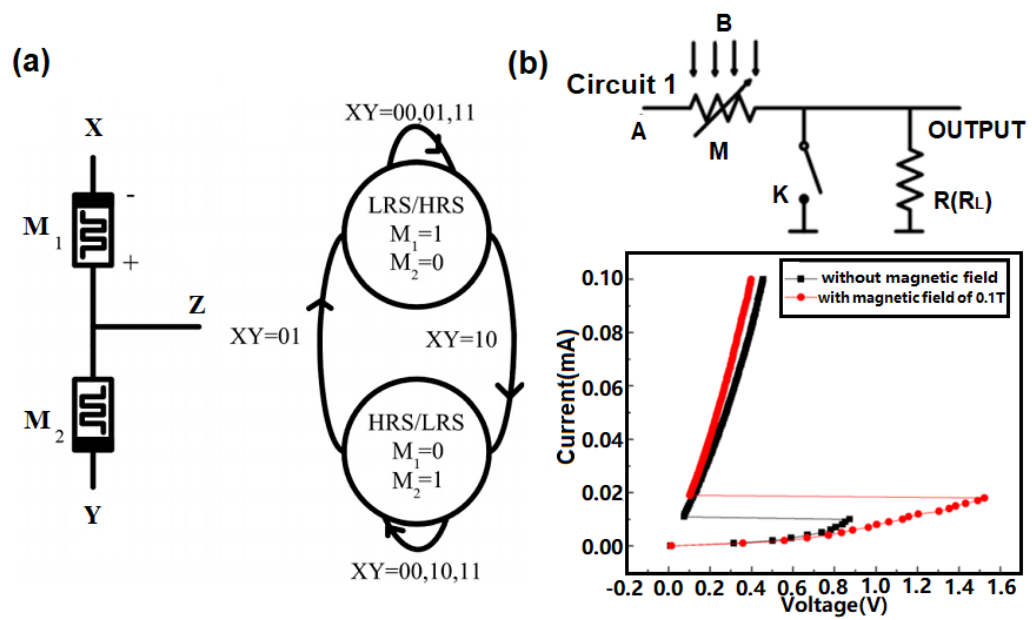
Figure 12. Other PCRAM-based approaches: ( a ) a memristor structure for logic operations with its corresponding state transition diagram; ( b ) an AND gate and the threshold voltage of phase-change materials with and without a magnetic field (( a ) is reprinted with permission from [127]; ( b ) is reprinted with permission from [129].)